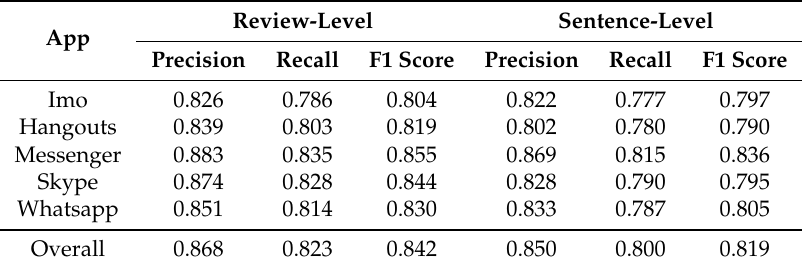
Table 1. Sentiment score accuracy